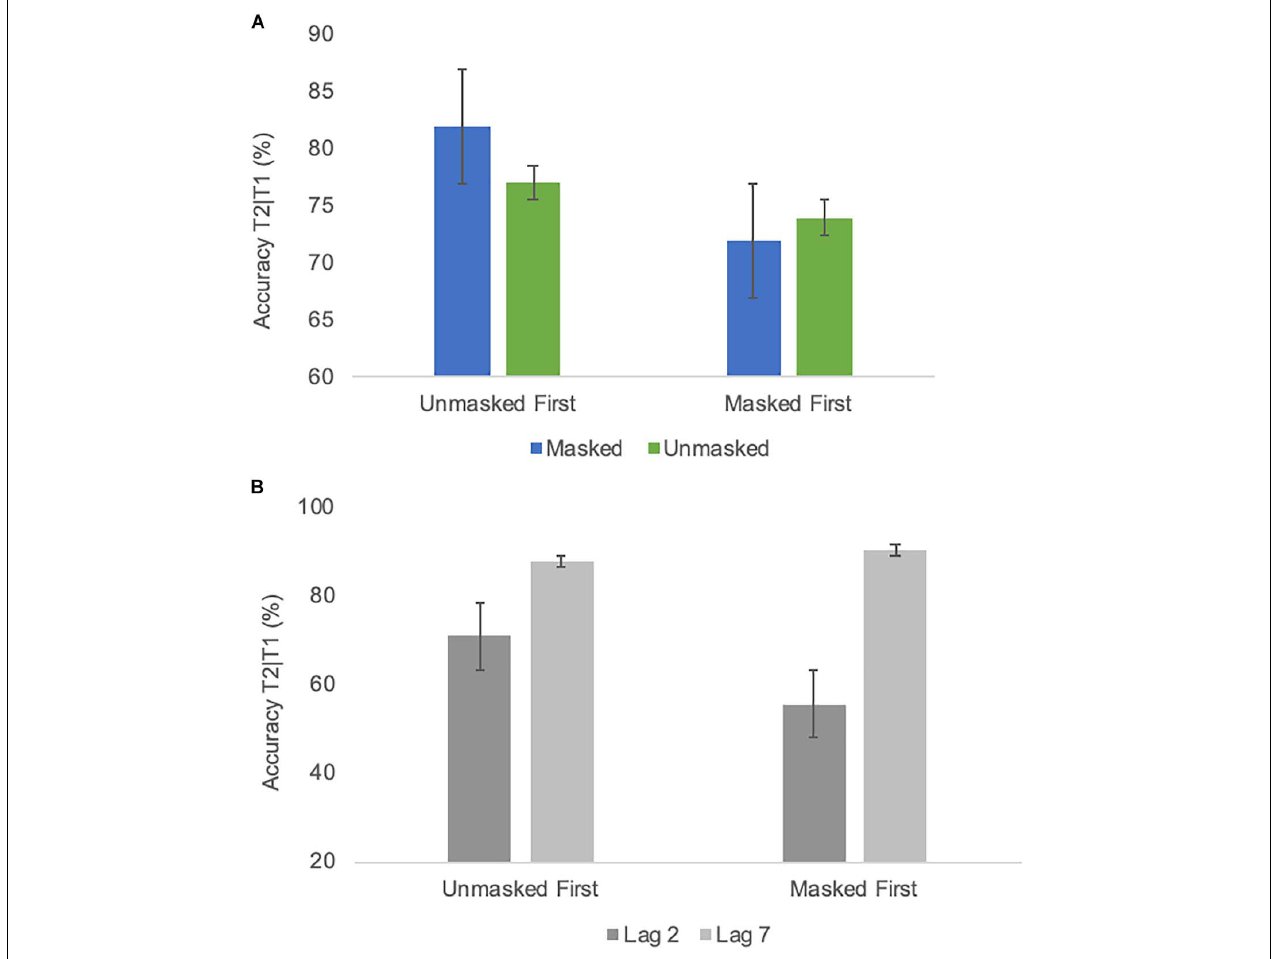
FIGURE 4 | (A) Average identification accuracy of T2 in different masking conditions of Experiment 1 in a group comparison (starting with the unmasked condition/starting with the masked condition). (B) Average identification accuracy of T2 at different lags of Experiment 1 in a group comparison (starting with the unmasked condition/starting with the masked condition). Error bars represent one standard error of the